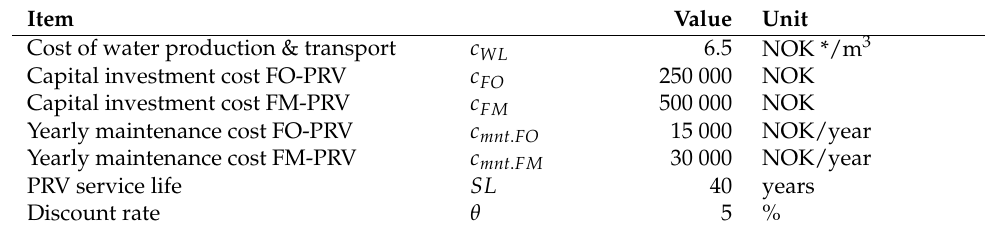
Table 2. Input parameters used to calculate maximal NPV of pressure reduction measures. Item